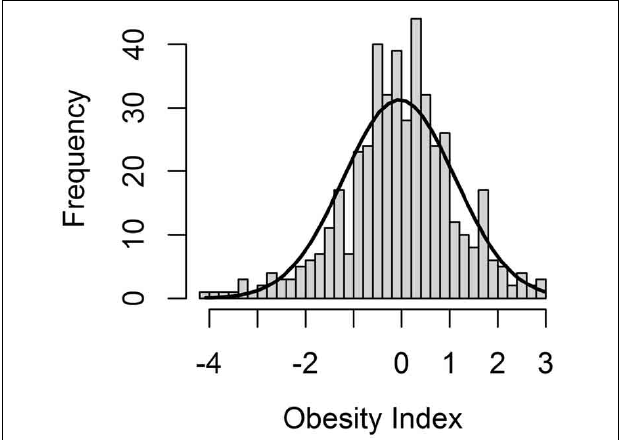
FIGURE 1 | Distribution of the Obesity Index (OI), an aggregate genotype representing the degree of obesity of all F2 animals in the F2 pig resource